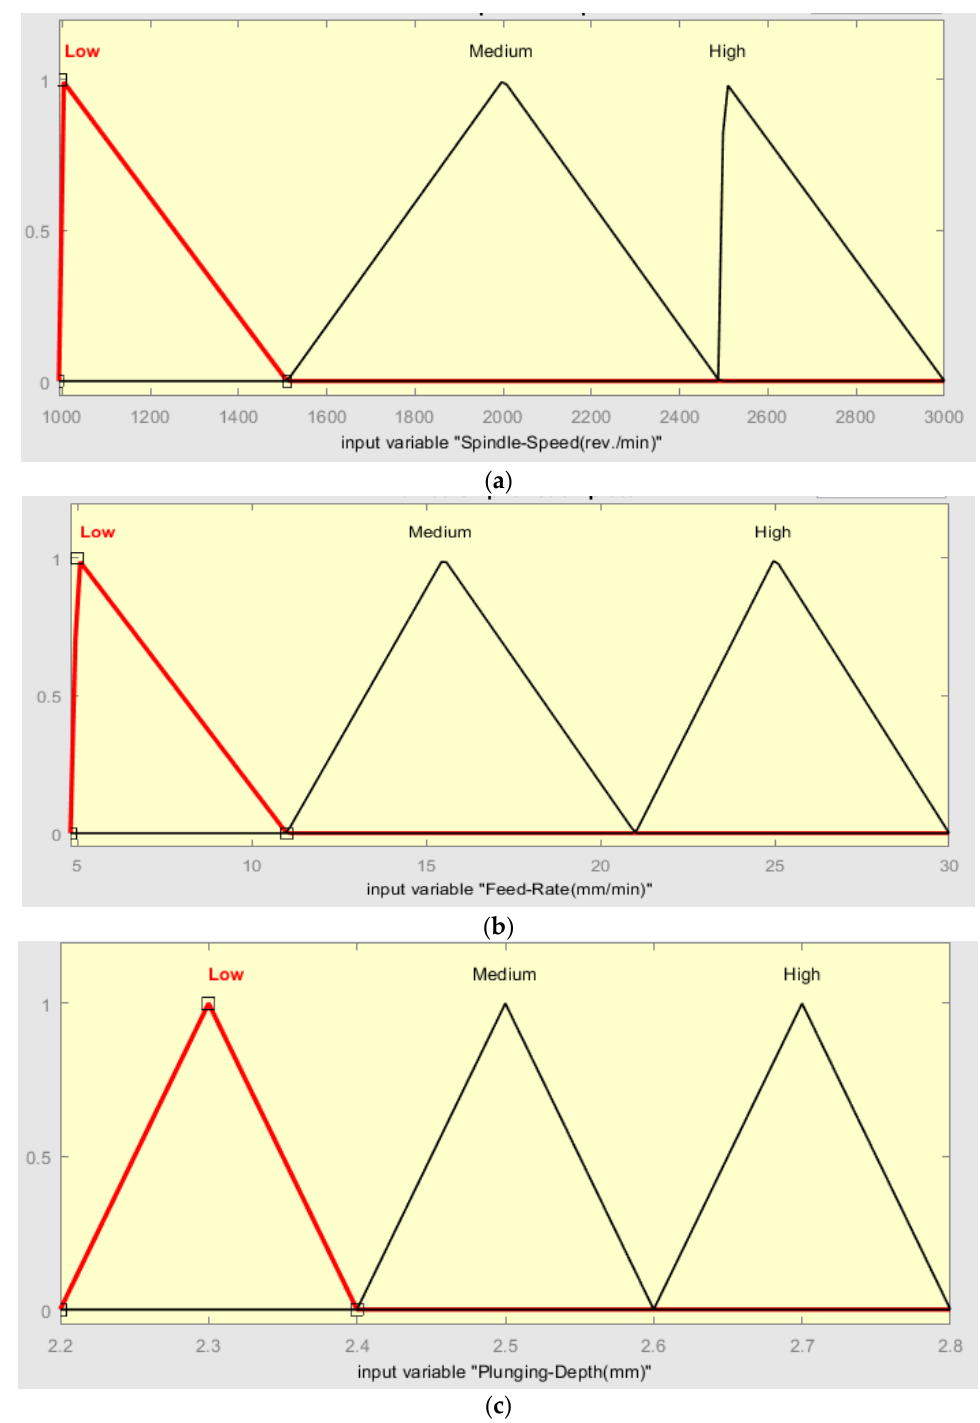
Figure 10. Triangular membership functions for fuzzy system inputs ( a ) SS, ( b ) FR, ( c ) PD. Table 6. Membership functions of FSSW strength fuzzy system inputs.